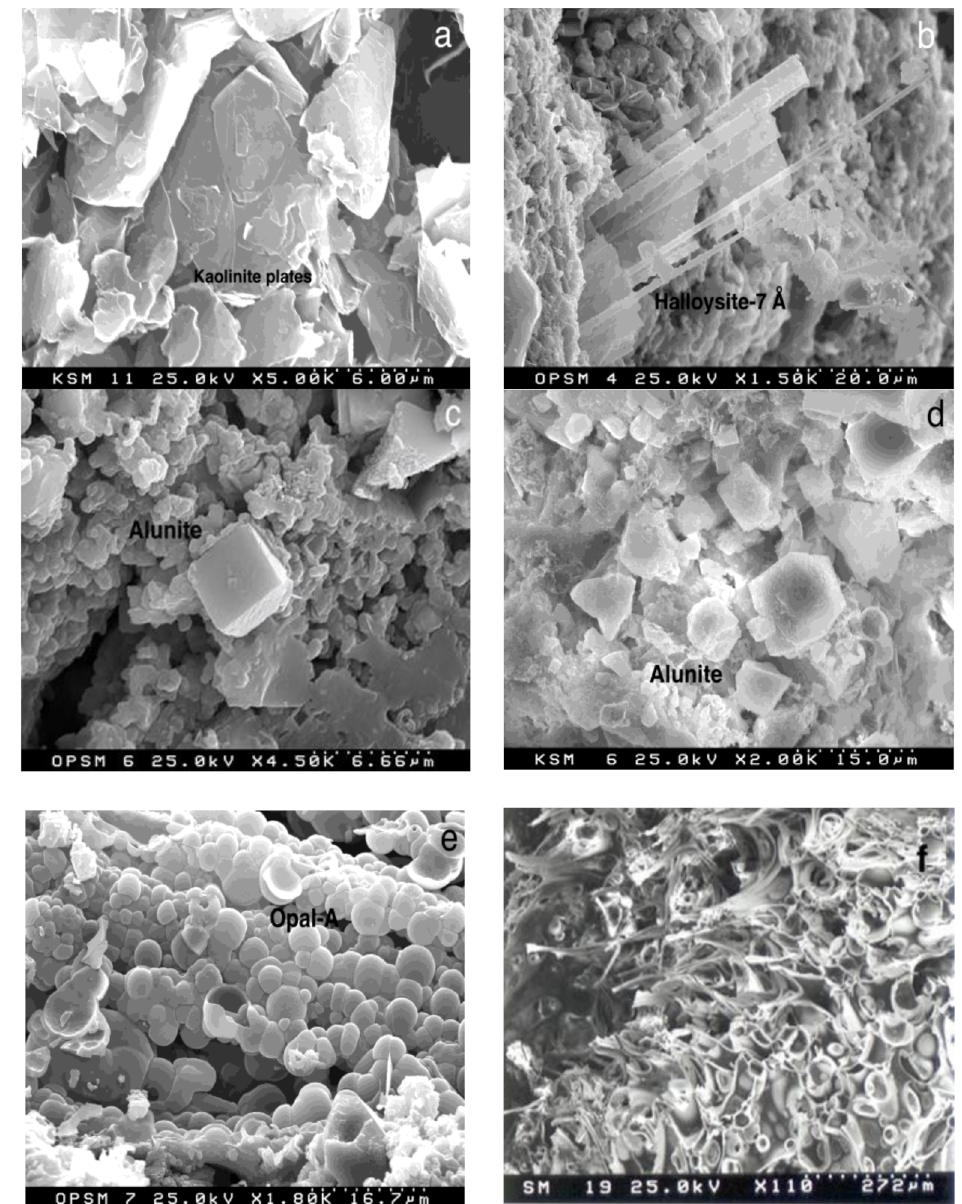
Figure 4. Scanning electron microscope images of kaolinite plates ( a ), halloysite-7Å tubes ( b ), alunite crystals ( c , d ), opal-A lepisphere ( e ) and volcanic glass dissolved in trachyte pumice rocks with embryonic opal-A formation ( f